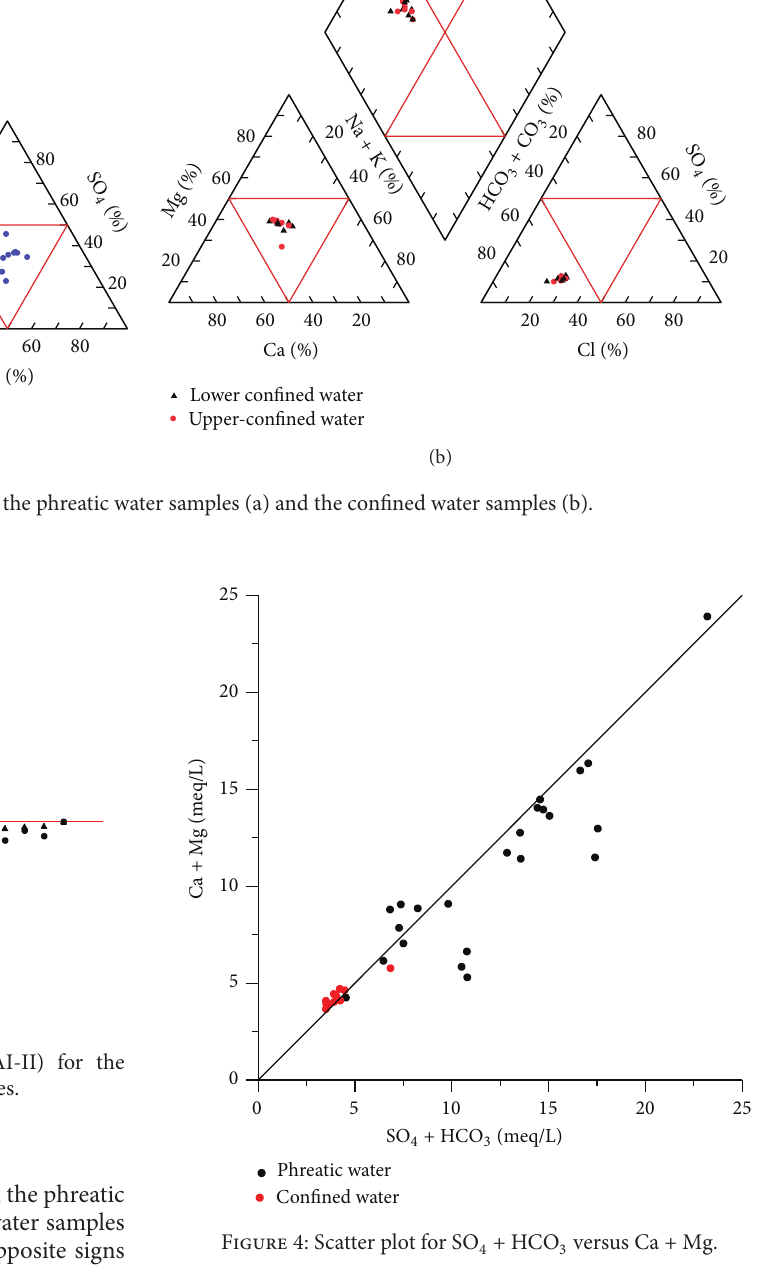
The ion exchange known as direct tends to shift the points because of the excess of (SO 42 − + HCO 3 − ) over (Ca 2+ + Mg 2+ ). Whereas the reverse ion exchange shifts the points to the left due to increased Ca 2+ and/or Mg 2+ released by rocks [47, 48]. Figure 4 showed 78% of the phreatic water samples are below the 1 : 1 line due to a deficiency of Ca 2+ and Mg 2+ .